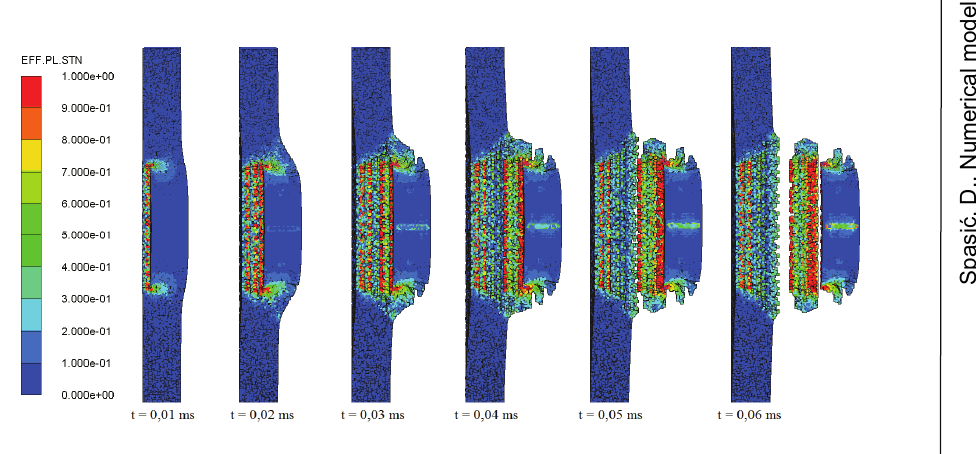
Figure 34 – Perforation of a 6 mm thick steel plate, hemispherical projectile (SFM